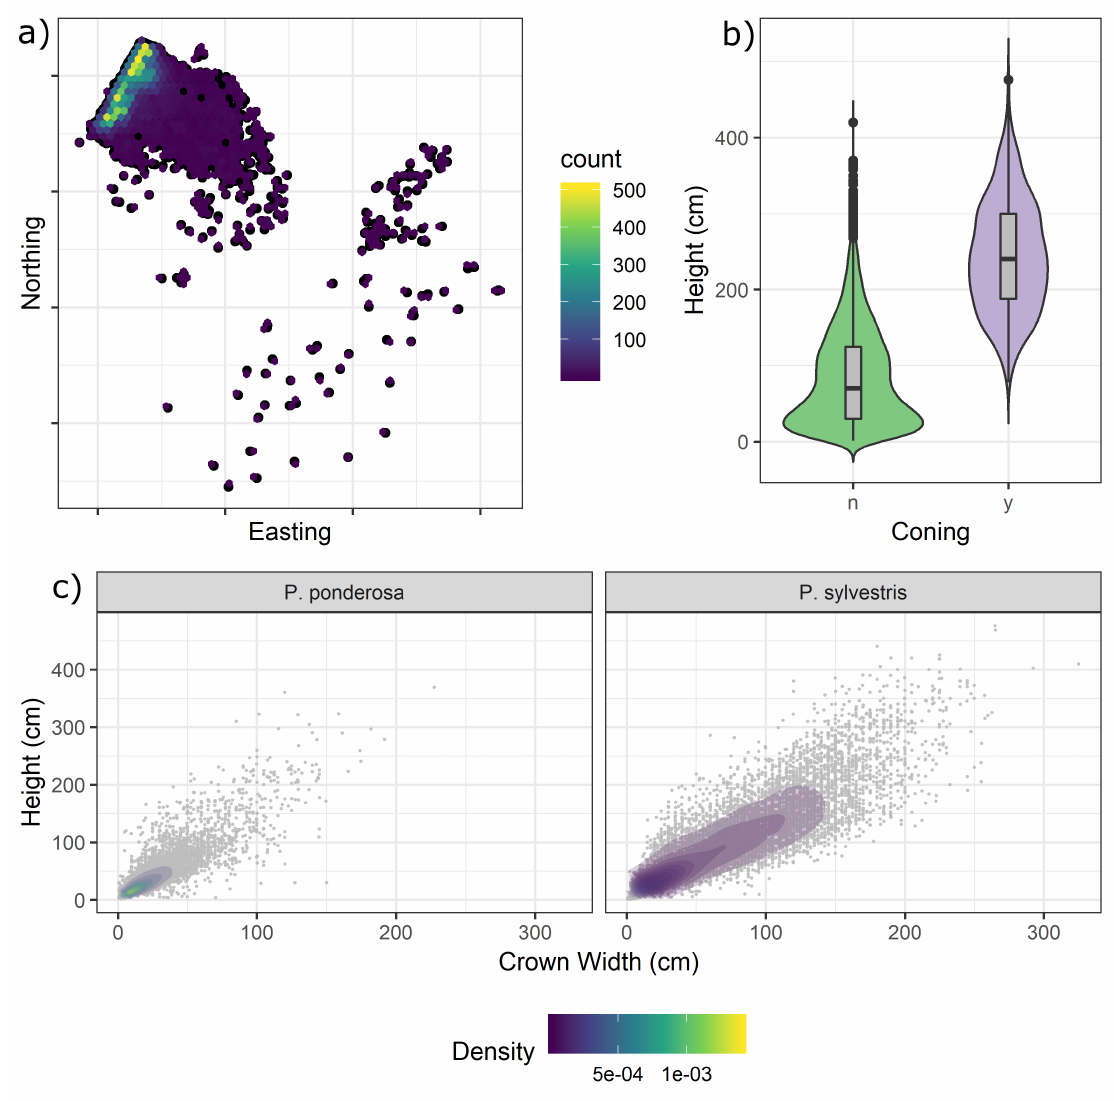
Figure 3. ( a ) A hexplot showing the spatial distribution and density of invasive conifers in the field dataset, ( b ) a violin and box plot showing the height distribution of non-coning (n) and coning (y) trees in the field dataset, and ( c ) the relationship between height and crown width for P. ponderosa and P. sylvestris